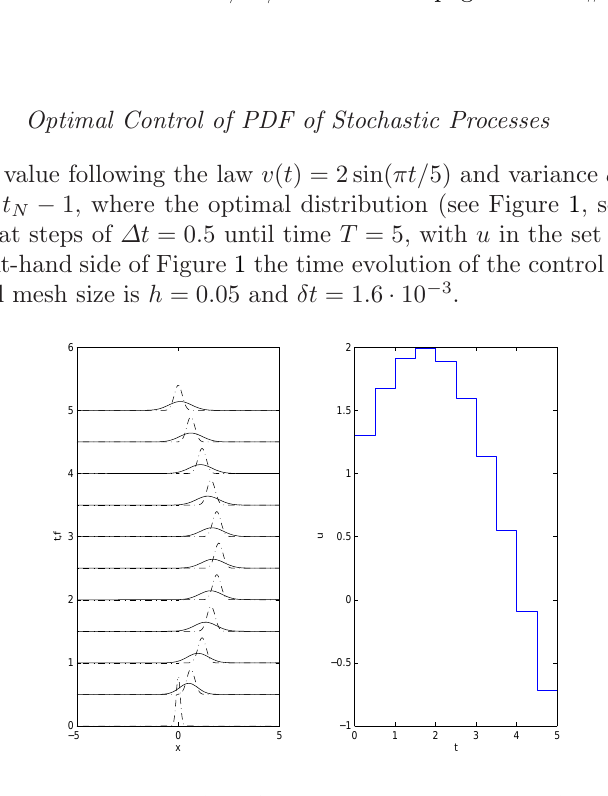
Figure 1. The optimal control of the Ornstein–Uhlenbeck process. Left–hand side: com- puted PDF (solid line) and desired PDF (dotted–dashed line) at different time windows. Right–hand side: The optimal control